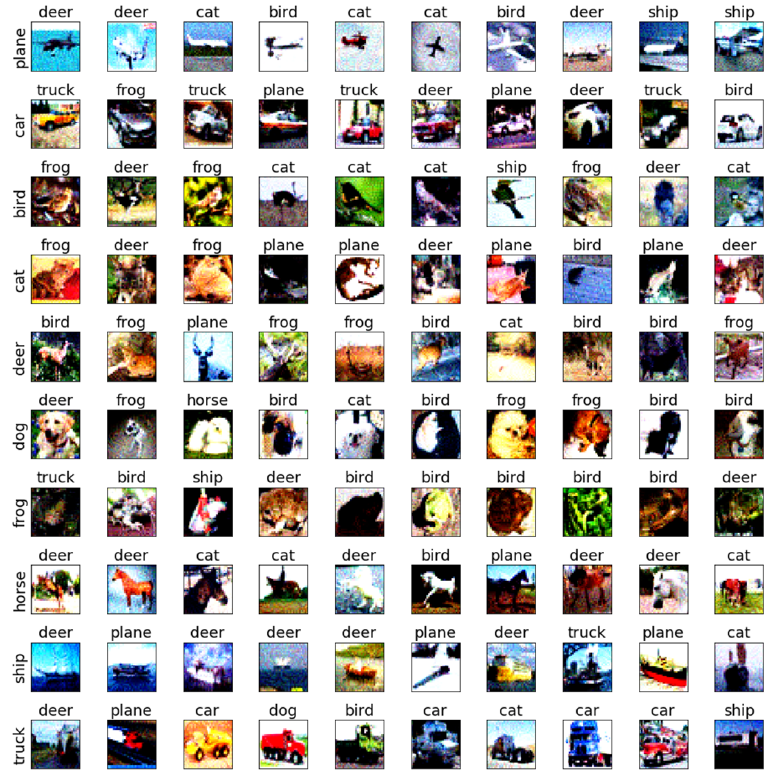
Figure 11. The adversarial examples of PGD for Cifar10 and AlexNet.